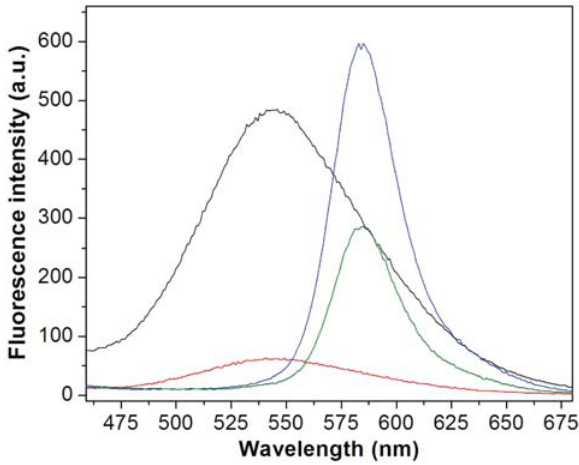
Figure 9. Fluorescence spectra of 10 μM RD (black) upon succes- sive addition of 8 μM Cu 2+ (red), 8 μM Hg 2+ (blue) and then 8 μM Cu 2+ (green).